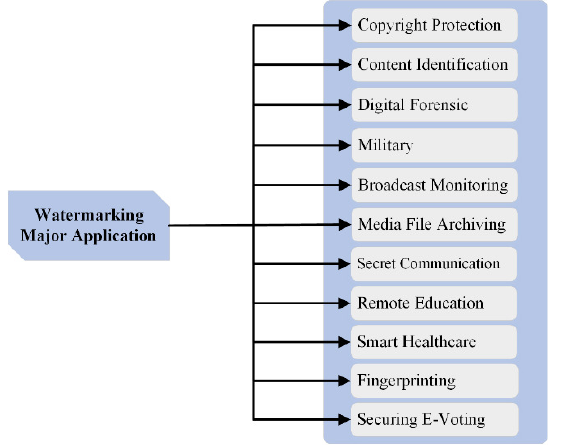
Fig. 1: Watermarking major applications